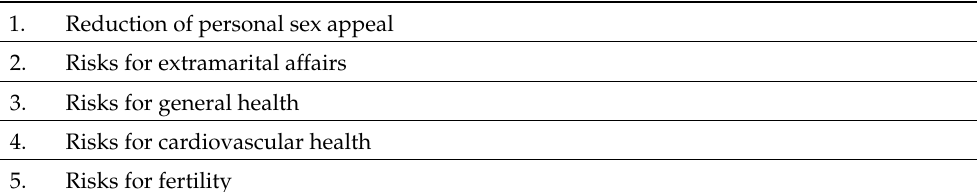
Table 6. The Viagra Jealousy, i.e., the principal reasons, explicit or implicit, for female dissatisfaction with the use of any kind of type 5 phosphodiesterase inhibitor in its conventional